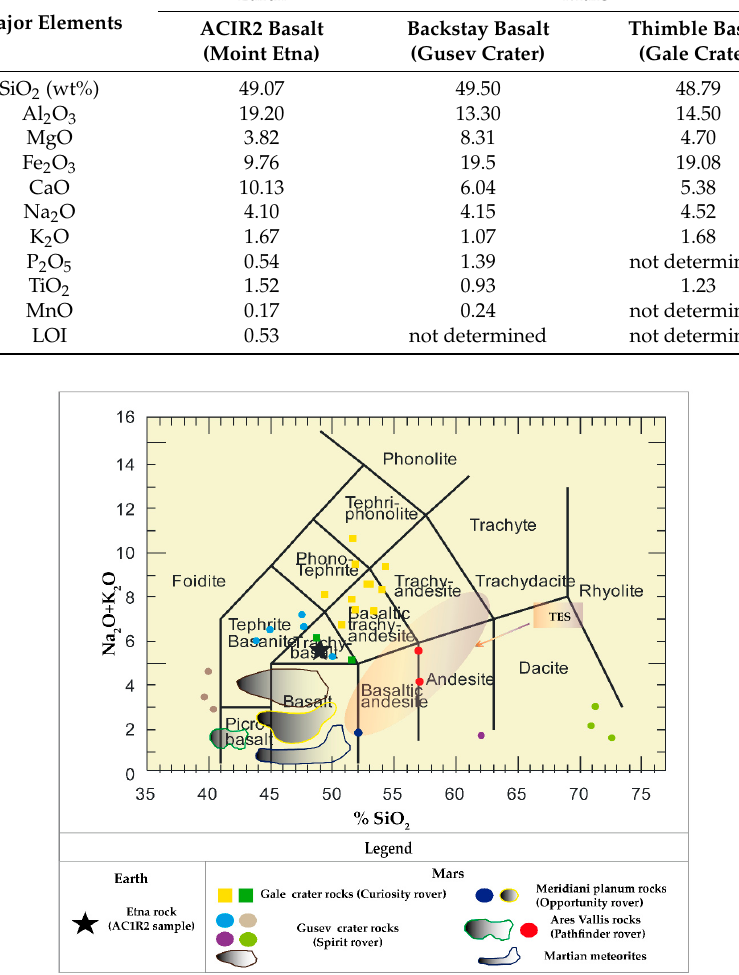
Figure 4. Total Alkali Silica diagram (TAS) showing the chemical composition of the Etna sample (black star) in comparison with composition of the Martian rocks so far estimated, from rover, orbiter and meteorite analyses as summarized by [7,55,56]. Thermal Emission Spectrometer (TES) is related to the measurements of rocks and soils on Mars carried out using the Thermal Emission Spectrometer onboard Mars Global Surveyor